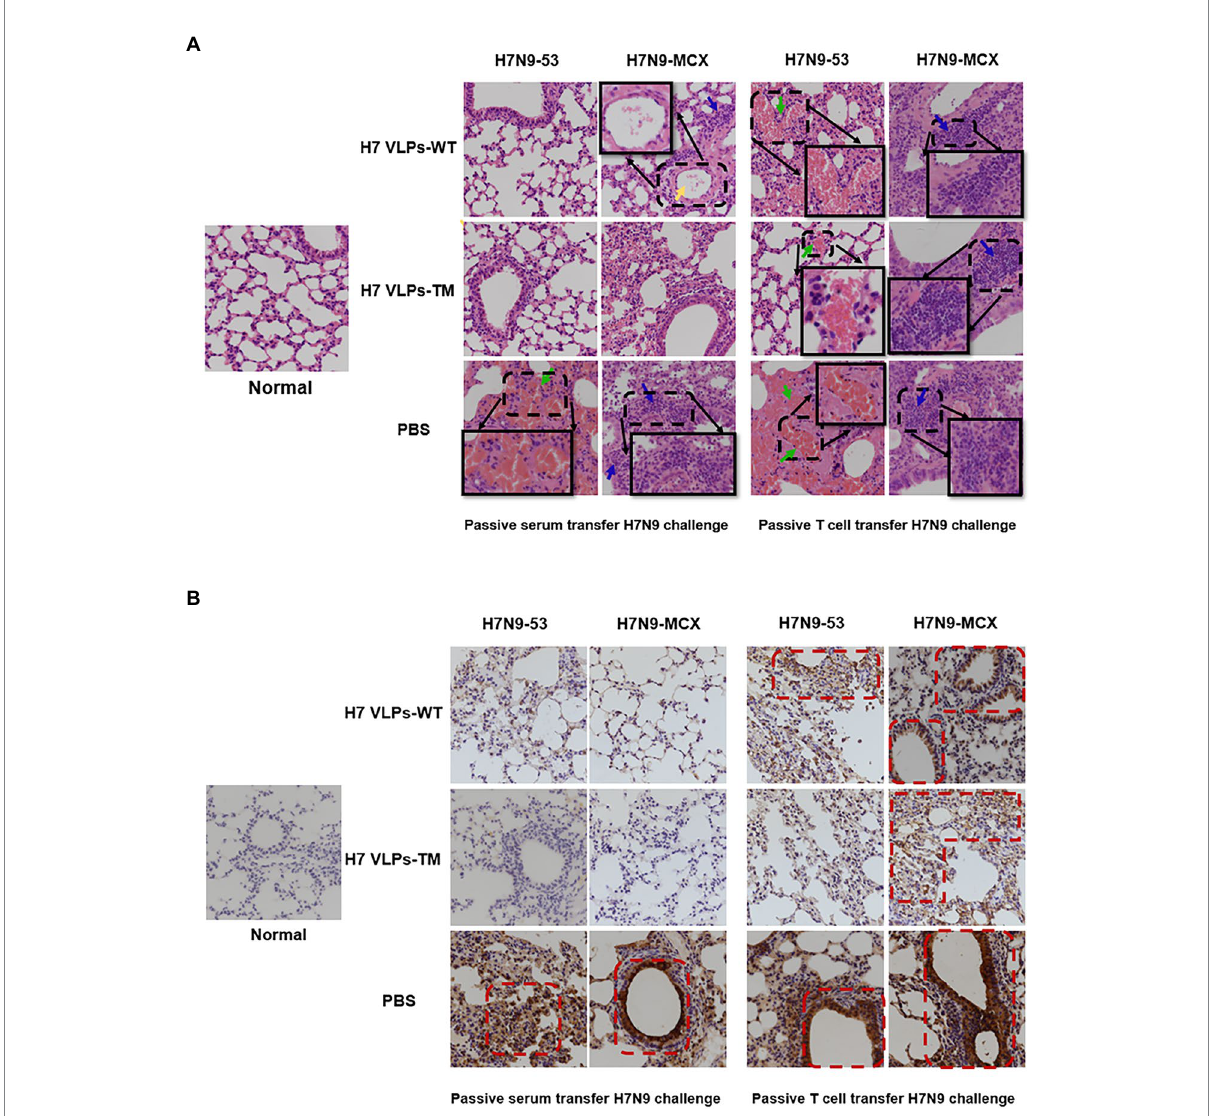
FIGURE 5 Pathological sections and immunohistochemistry of the lungs of passively immunized mice challenged with poison (400×). (A) Histopathology examination (the green arrow represents congestion and bleeding, blue arrows represent lymphocyte infiltration, and yellow arrows represent exfoliated cells in the alveolar cavity). (B) Immunohistochemistry showing expression of influenza NP in lung sections. NP,